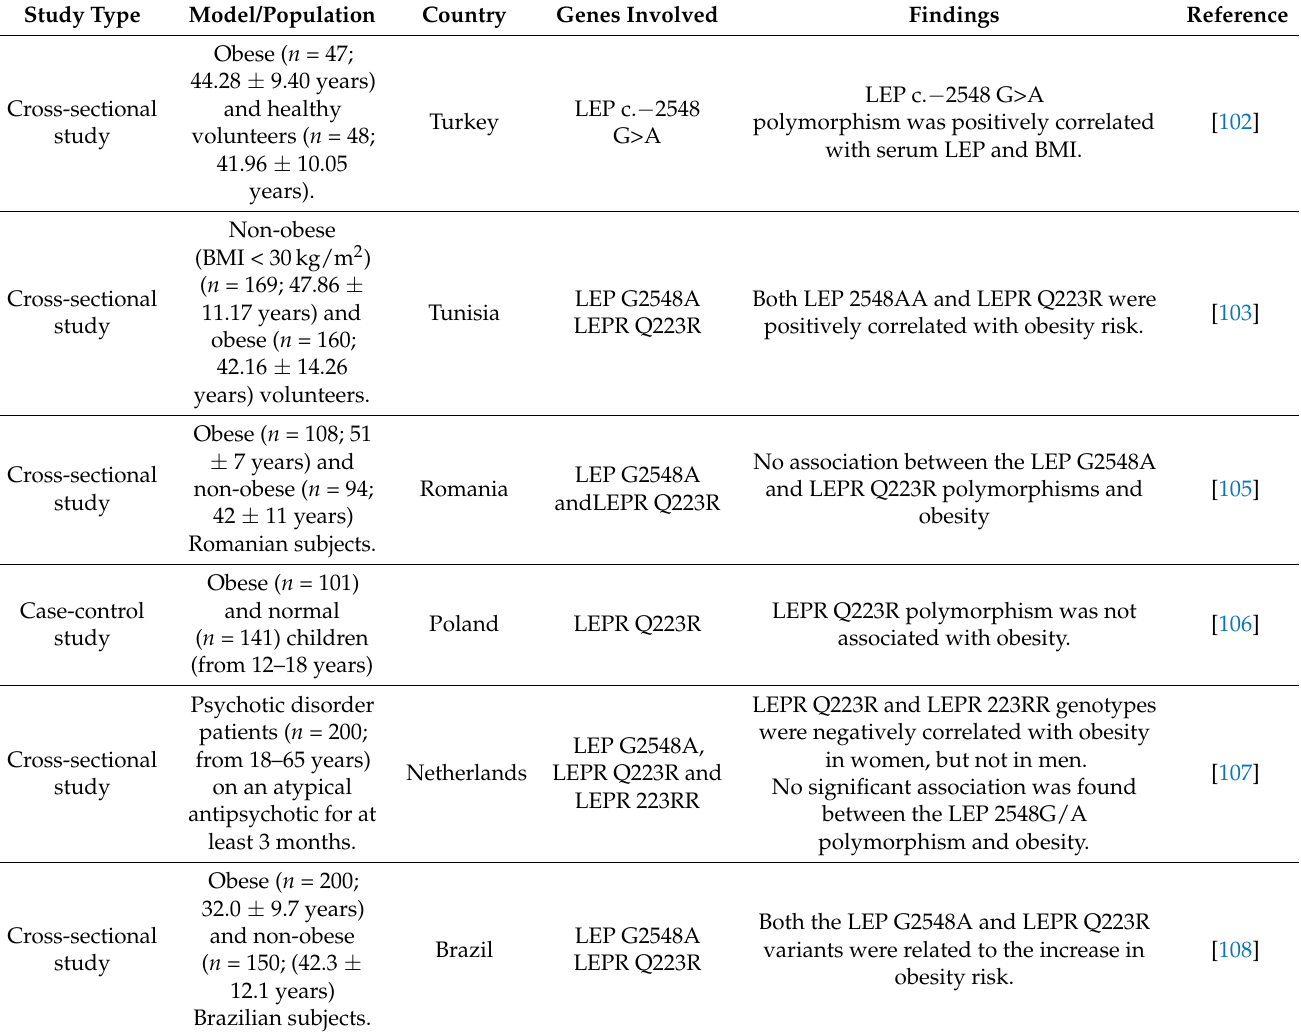
Table 5. The relationship between leptin, leptin receptor and